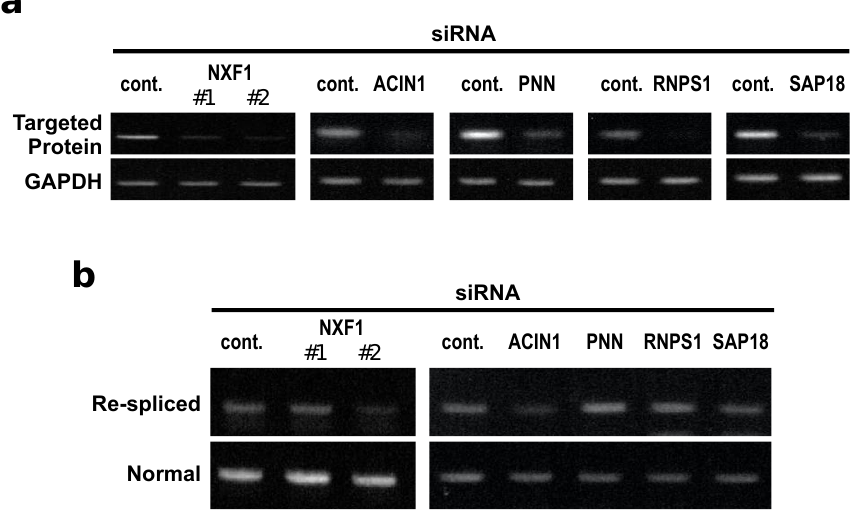
Figure 4. Depletion of EJC peripheral factors, including an mRNA export factor, have no significant effects on mRNA re-splicing in MCF-7 cells: ( a , b ) To knock-down the expression of endogenous EJC peripheral factors (NXF1, ACIN1, PNN, RNPS1, SAP18), MCF-7 cells were transfected with the indicated siRNAs. To observe the knocked-down efficiency and TSG101 re-splicing activity, the extracted total RNAs were analyzed by RT – PCR.